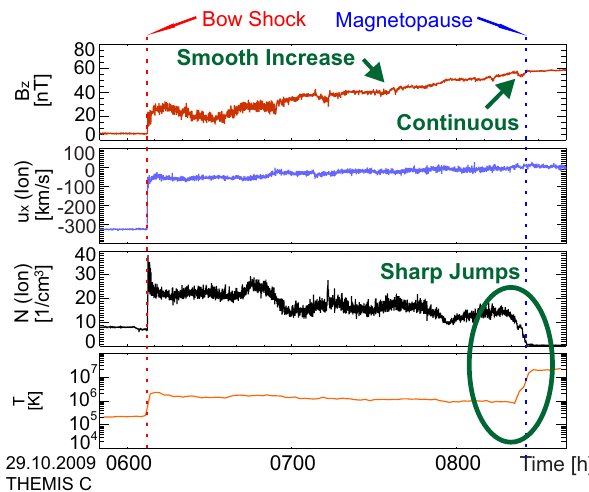
Fig. 1. A low-shear magnetopause transition on 29 October 2009. The upper panel shows B z (GSM) magnetic field observations. The second panel displays the (ion) velocity in x-direction (GSM), and the third one shows the density of the plasma ions. The last panel depicts the logarithmic ion